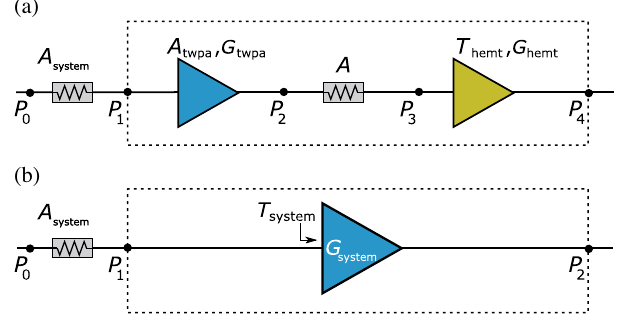
FIG. 14. Schematic representation of the system in terms of attenuators and amplifiers. (a) The system attenuation is A . system Inside the dotted box, there is the STWPA, modeled as an attenuator combined with a lossless amplifier, followed by an unknown attenuation A and the rest of the chain (HEMT and room-temperature amplifier), whose input noise is dominated by the HEMT noise. (b) Simpler modeling of the system as a single amplifier G , whose input noise T depends on whether system system or not the STWPA pump is turned on.